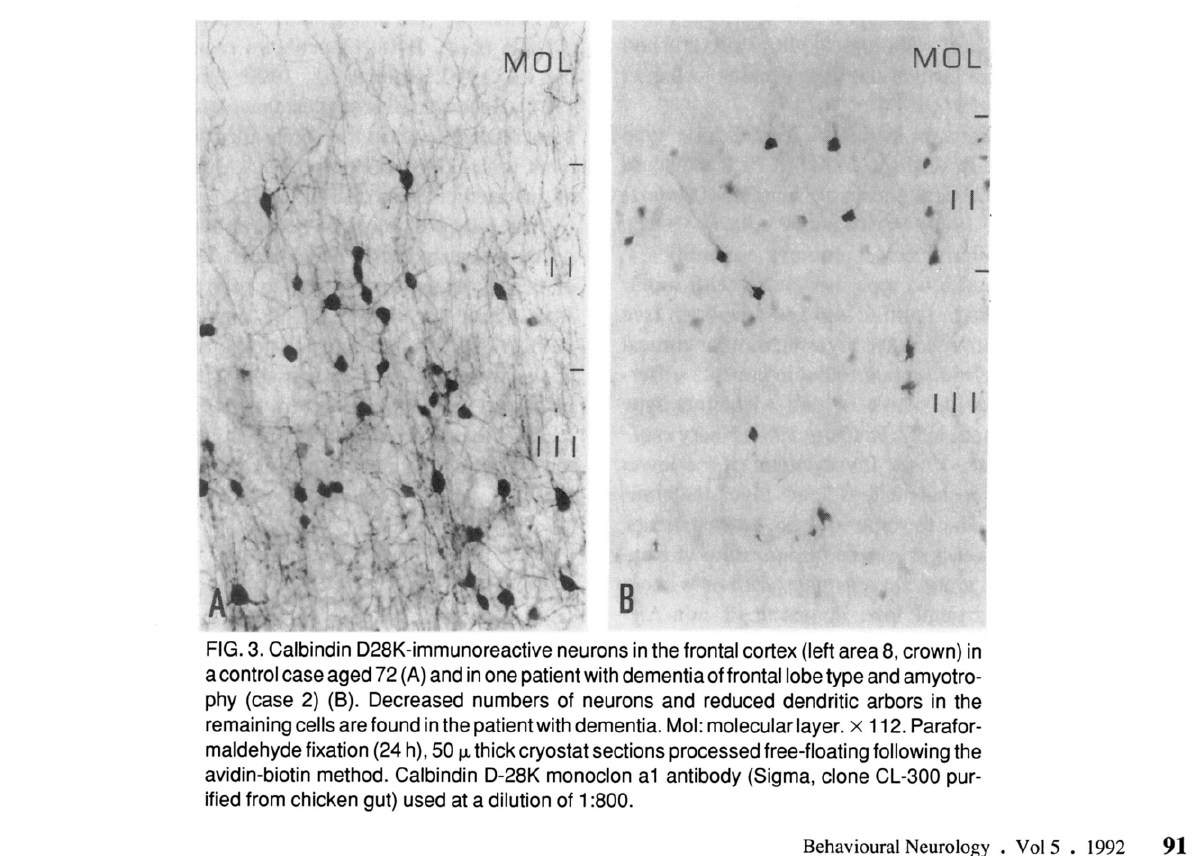
FIG. 3. Calbindin D28K-immunoreactive neurons in the frontal cortex (left area 8, crown) in a control case aged 72 (A) and in one patient with dementia of frontal lobe type and amyotro phy (case 2) (8). Decreased numbers of neurons and reduced dendritic arbors in the remaining cells are found in the patient with dementia. Mol: molecular layer. x 112. Parafor maldehyde fixation (24 h), 50 fl. thick cryostat sections processed free-floating following the avidin-biotin method. Calbindin D-28K monoclon a1 antibody (Sigma, clone CL-300 pur ified from chicken gut) used at a dilution of 1